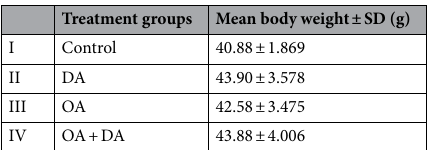
Table 1. Mean body weights (g) ± SD of Swiss Albino mice as per the treatment groups at the start of experimental